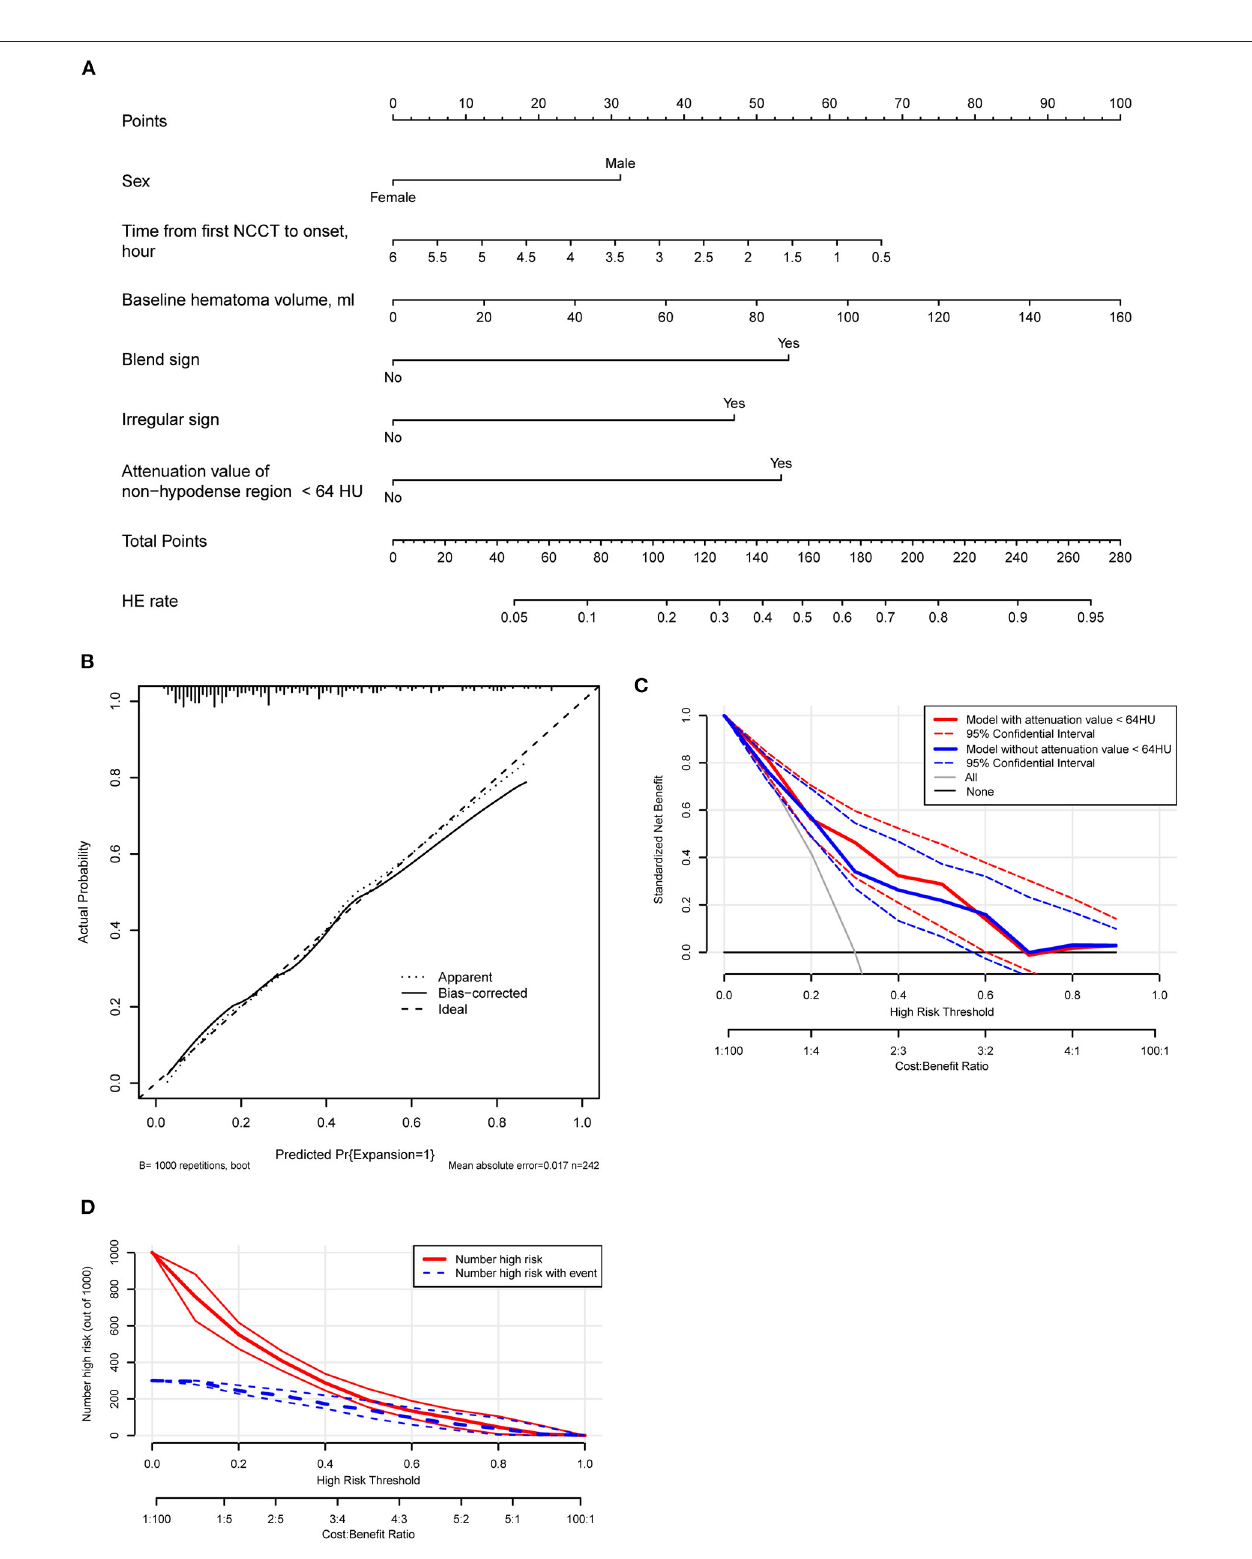
FIGURE 7 | (A) A nomogram is derived from the multivariate analysis. (B) Calibration plot of the nomogram model. (C) A decision curve analysis of the model with or without incorporation of the attenuation value of the non-hypodense region of hematoma. The model with six variables has a higher net benefit when the expansion risk threshold varies between 0.3 and 0.6. (D) Clinical impact curve analysis. The actual events and the predicted events are close while the risk of threshold exceeds about 0.5.